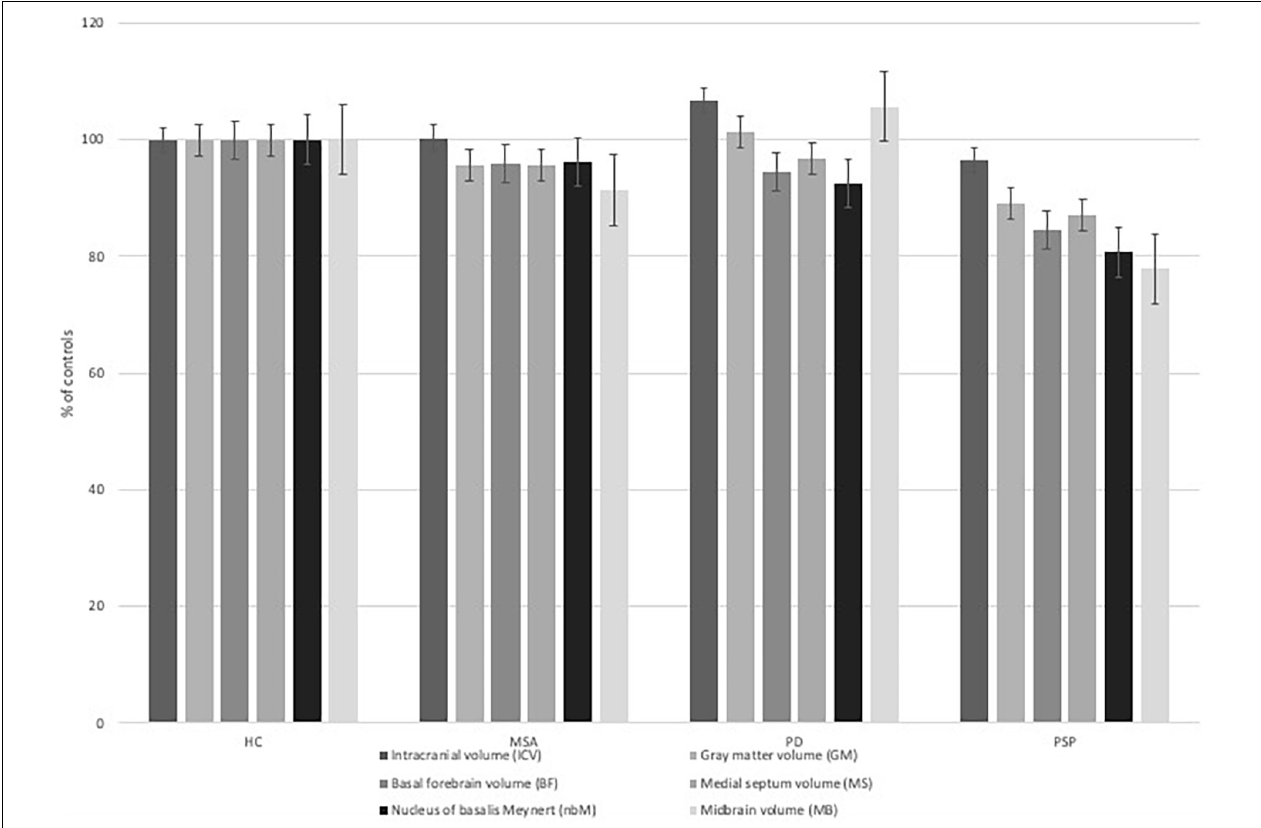
FIGURE 3 | Brain volumes of interest per diagnosis in relation to healthy controls (HC). The bar chart displays different volumes of interest [Intracranial volume (ICV), gray matter volume (GM), basal forebrain volume (BF), medial septum volume (MS), nucleus of Meynert volume (nbM), midbrain volume (MB)] in relations to the volumes measured in healthy controls in